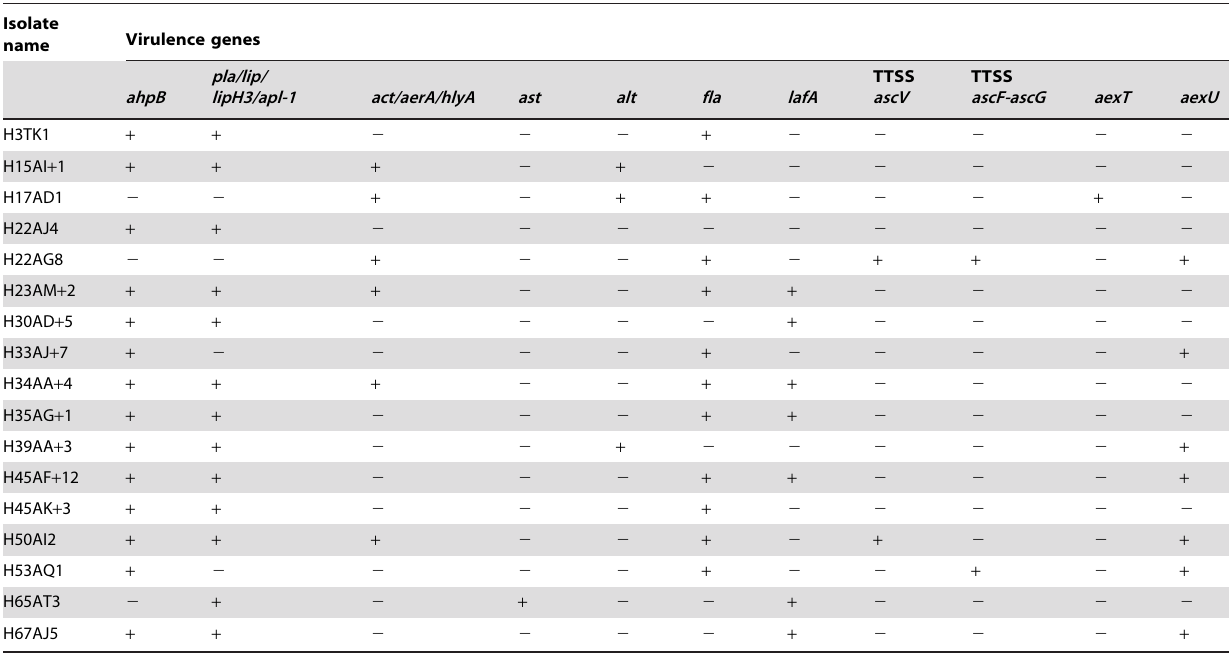
Table 1. Prevalence of virulence genes in Aeromonas isolates from diarrheal patients.